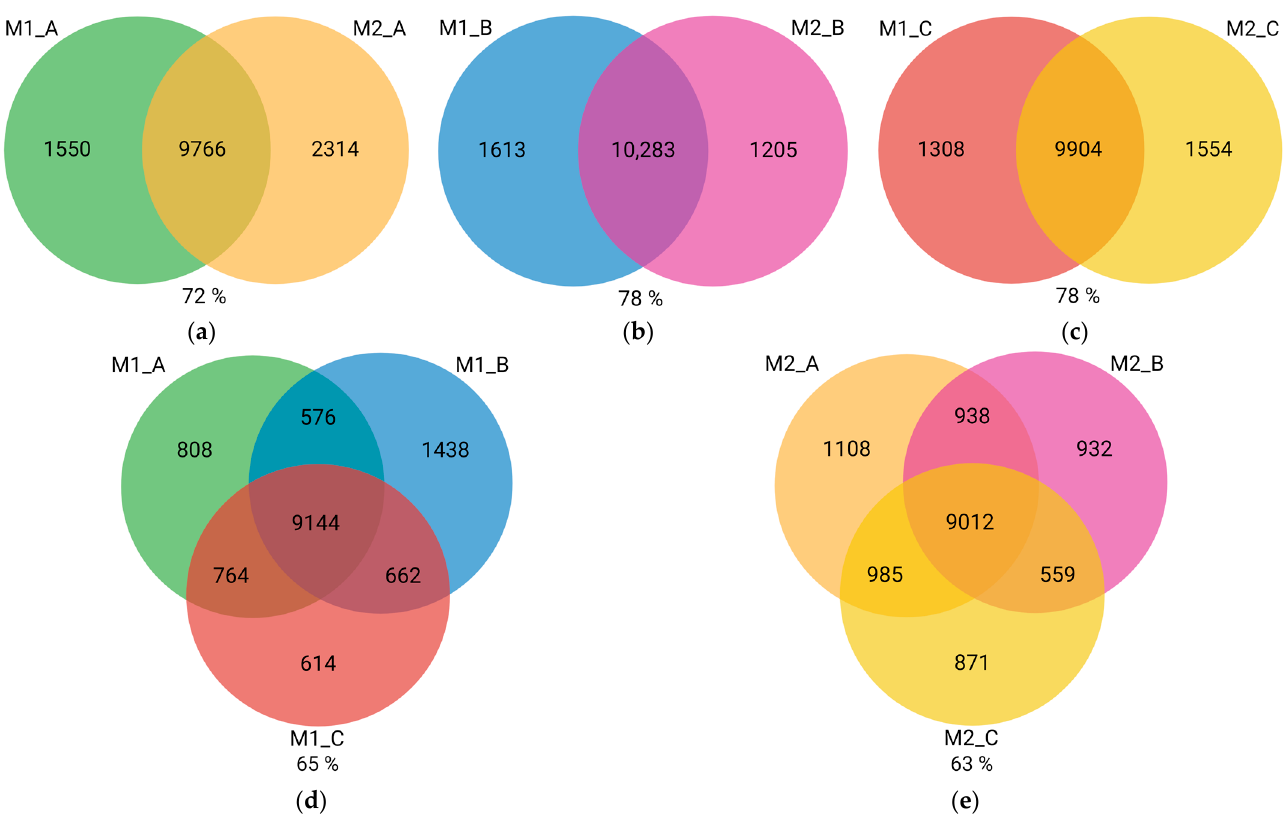
Figure 5. Venn diagrams of co-expression. Numbers of uniquely expressed and co-expressed genes are shown inside the circles. Percentages of the genes that are co-expressed out of all expressed genes are displayed below each diagram. ( a ) Protocol A; ( b ) Protocol B; ( c ) Protocol C; ( d ) M1 macrophages; ( e ) M2 macrophages. Created with BioRender.com; accessed on 3 rd February 2023. Table 1. M1 gene sets for differential gene expression